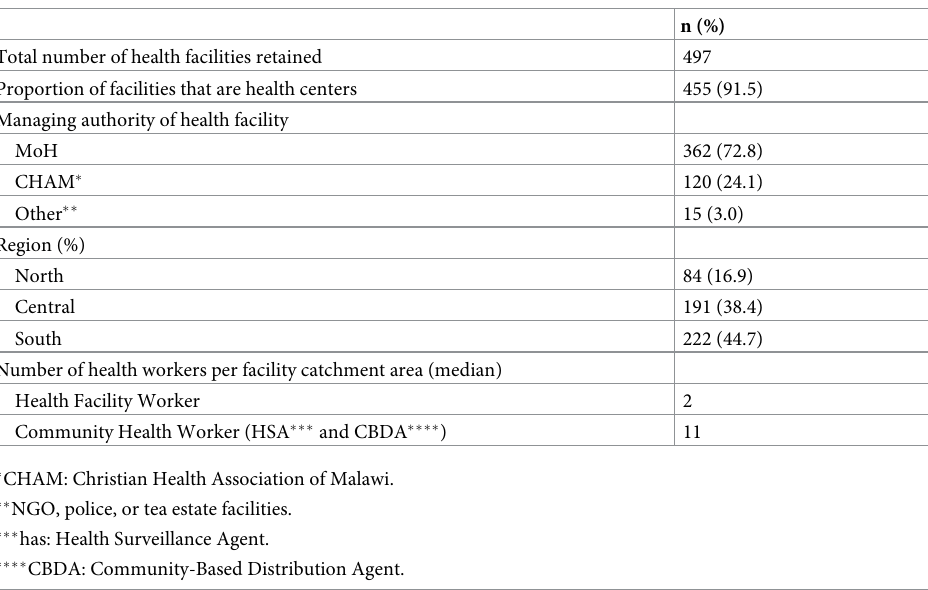
Table 2. Background characteristics of rural health